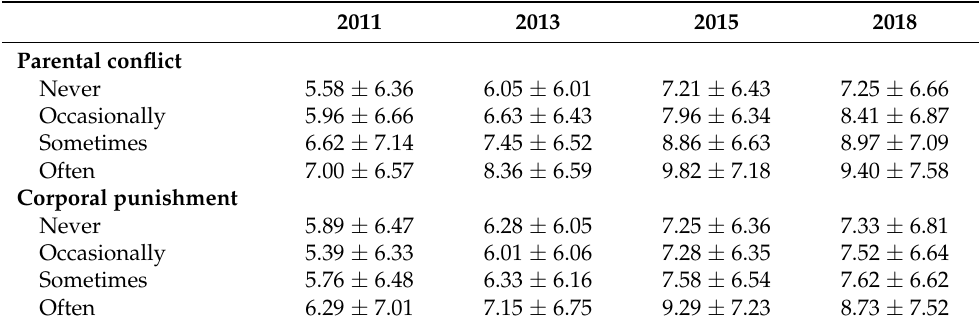
Table 2. Depressive symptoms across groups with different EDV.